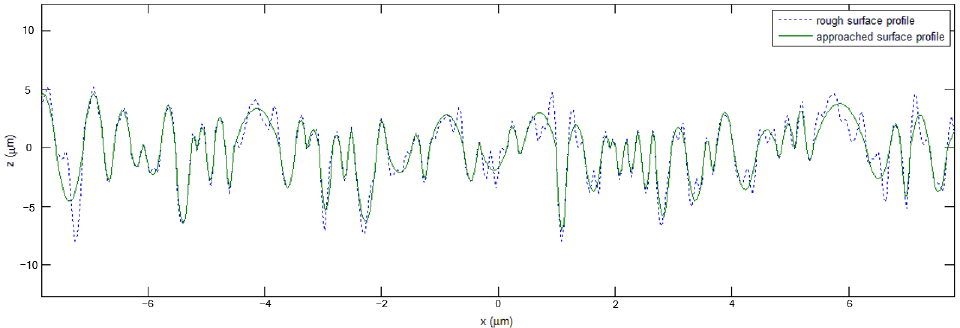
Figure 3. Aramaki’s roughness approximation.